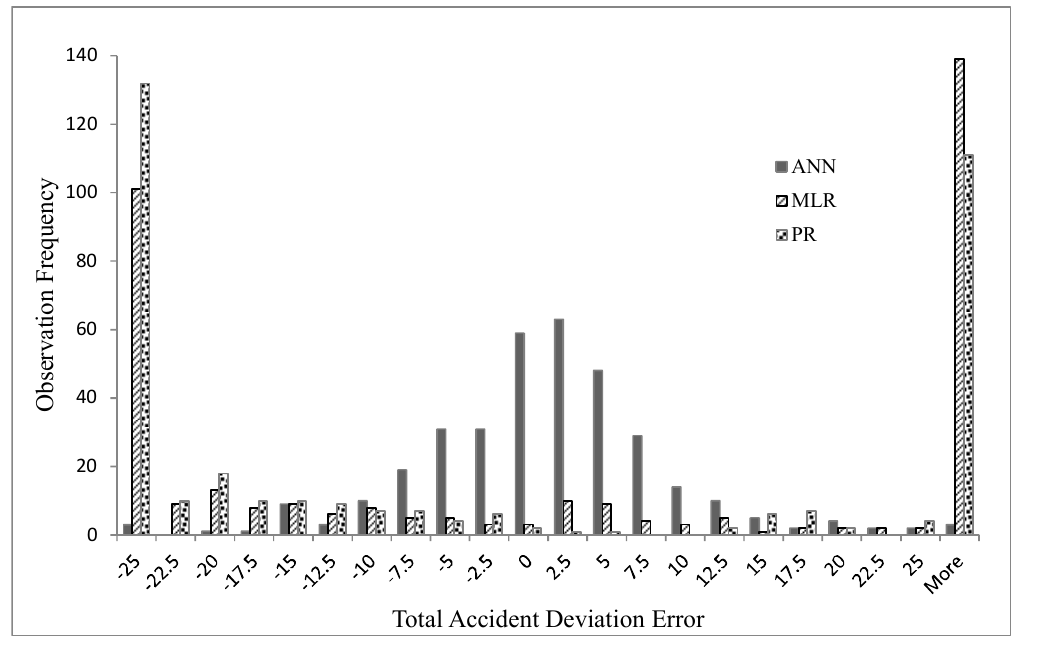
Figure 5. Error histograms of the ANN, MLR, and PR models. Table 3. ANN model vs. MLR model performance.